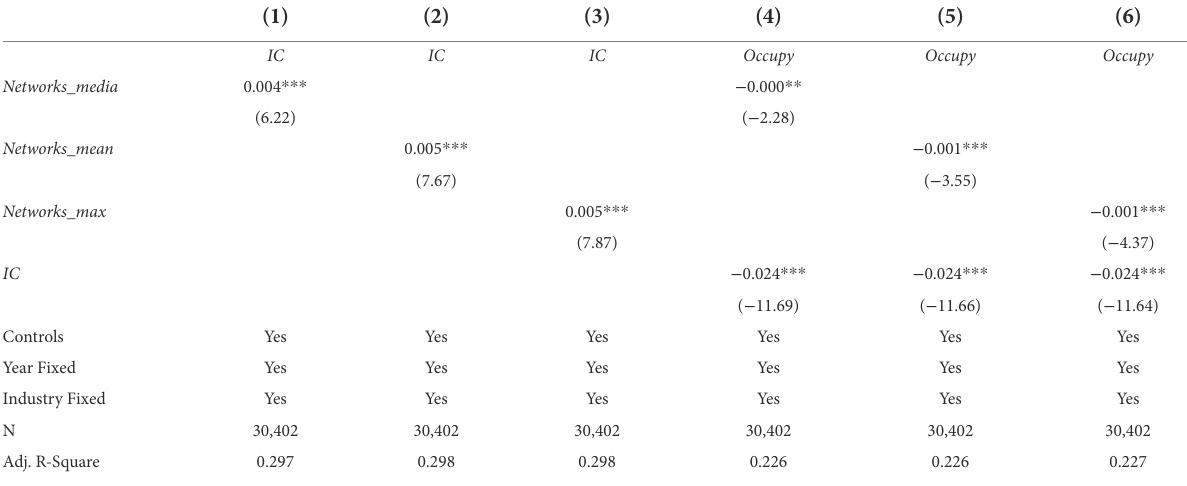
TABLE 7 Mediating effect.